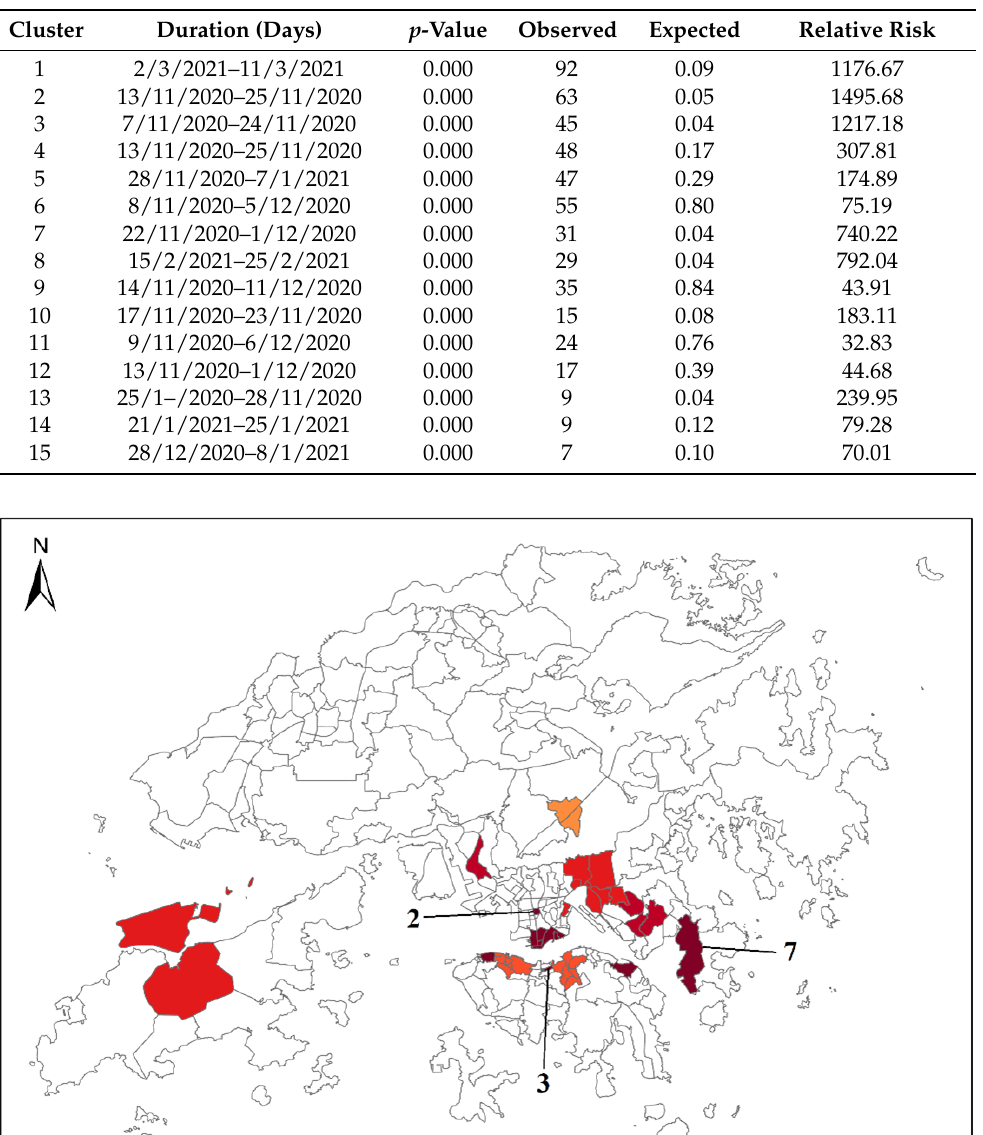
Table 8. Space–time clusters in stage III of COVID-19 transmission in non-residential locations in Hong Kong.